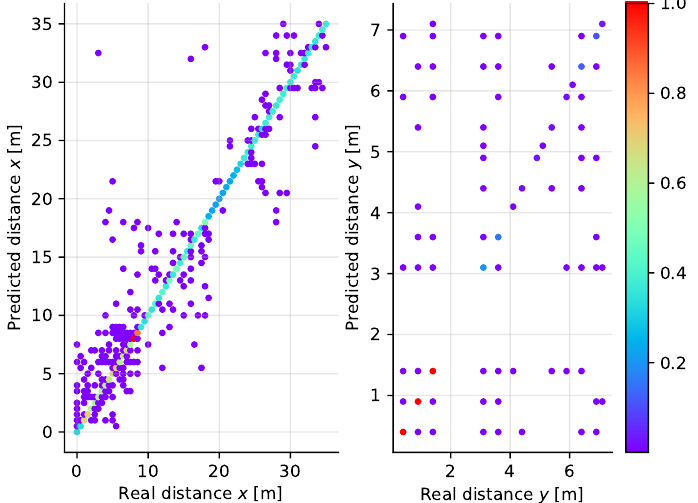
Figure 19. Scatter plot diagram of the real and predicted distance along the X ( left ) and Y ( right ) axes for the Multi-Layer Perceptron classifier applied to two-dimensional